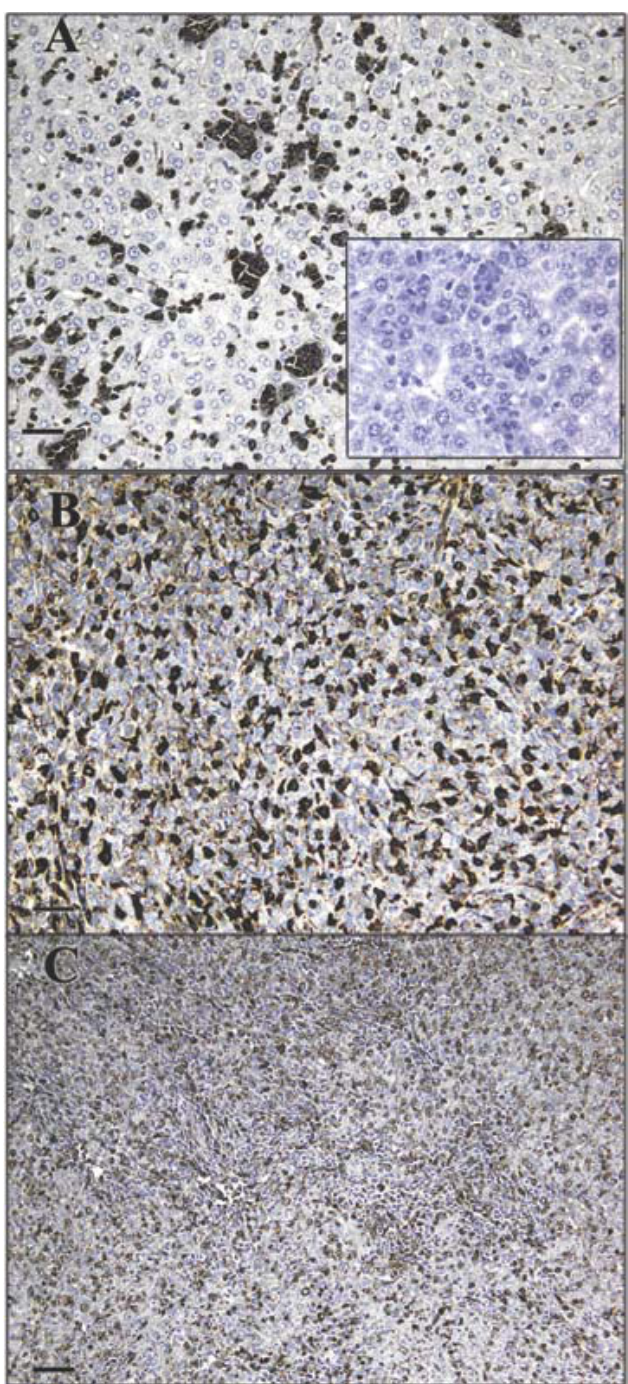
Figure 1. Expression pattern of GS-I binding to tumor cells. Murine 4T-1 tumor transplants were labeled with 2.5 μ g/mL GS-I. Metastatic tumor cells in the liver ( A ) and lung ( B ) demonstrate increased GS-I binding compared to cells within the primary tumor ( C ). 200× magnification, bars equal 40 μ m. No staining is observed in sections stained with biotin alone ( inset, A